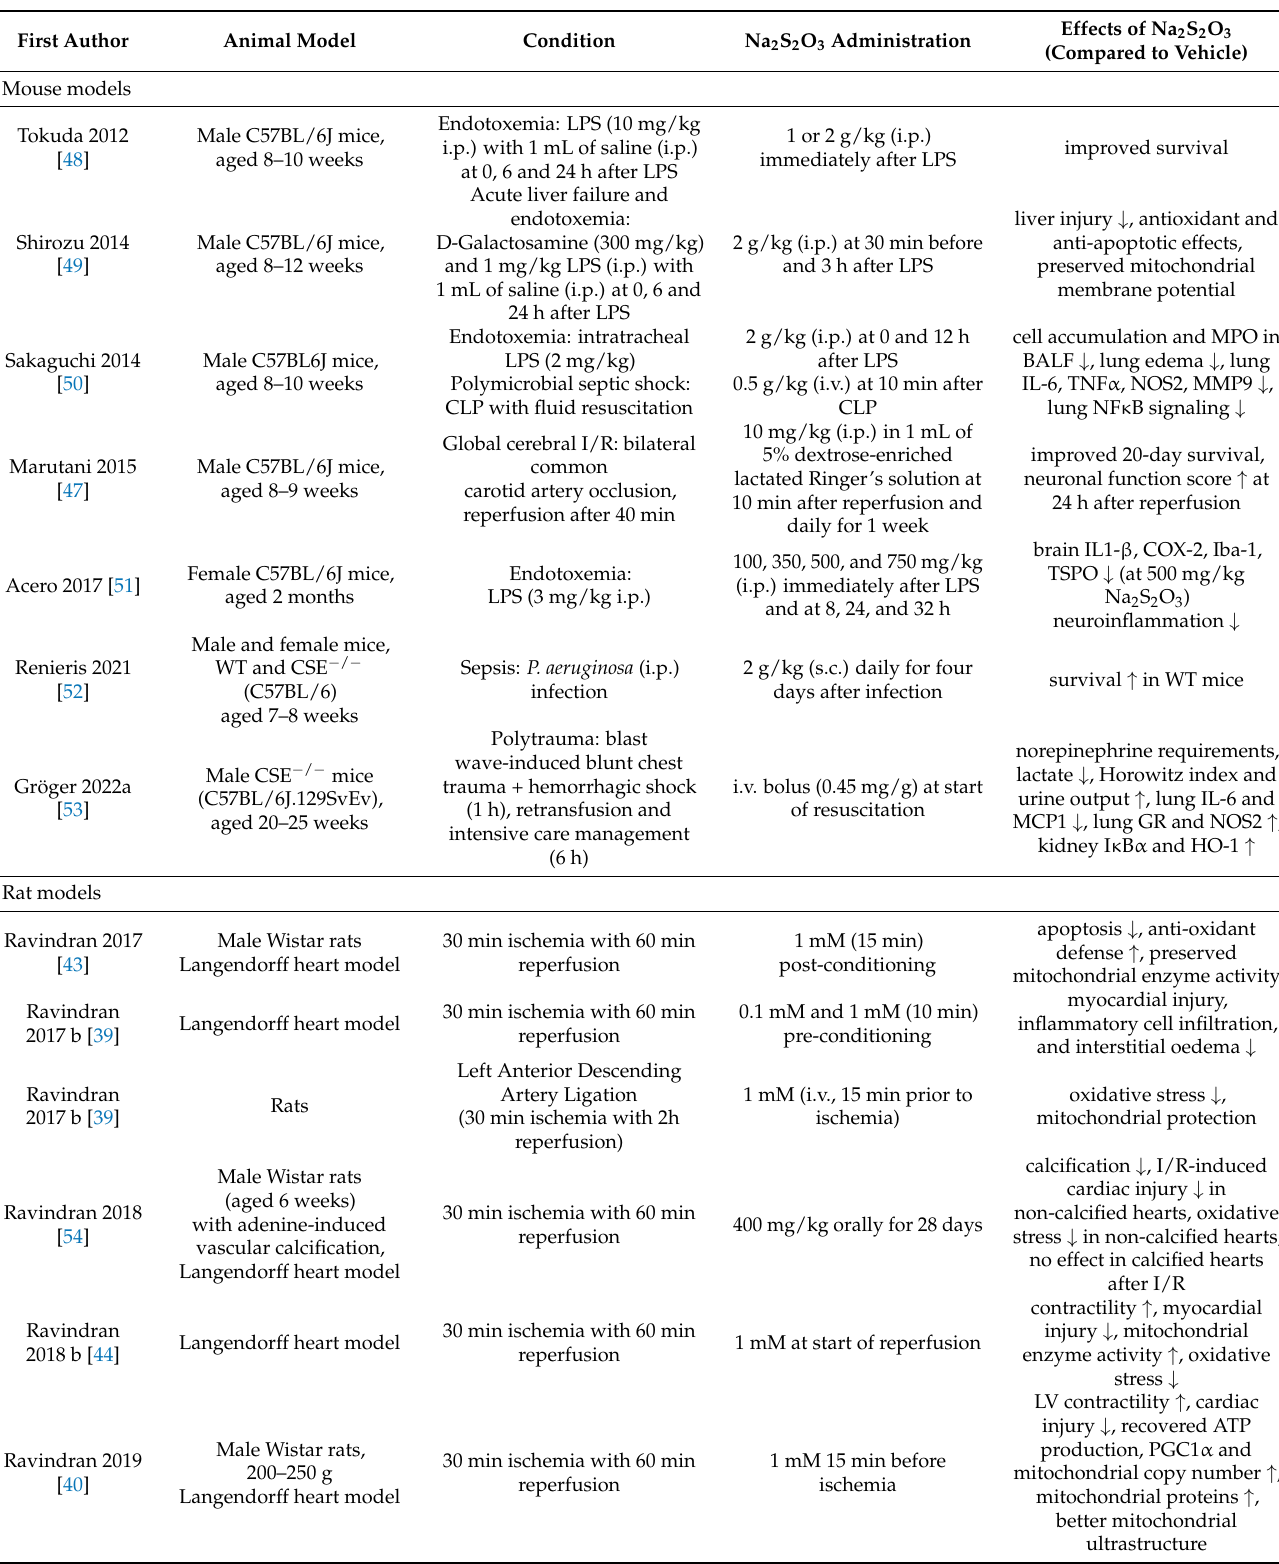
Table 1. Summary of in vivo/ex vivo studies investigating the effects of Na 2 S 2 O 3 in models of critical